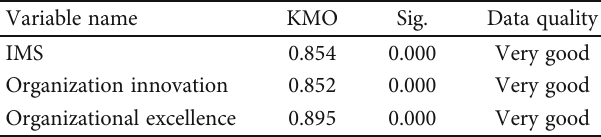
Table 6: KMO values in the Bartlett ’ s test.